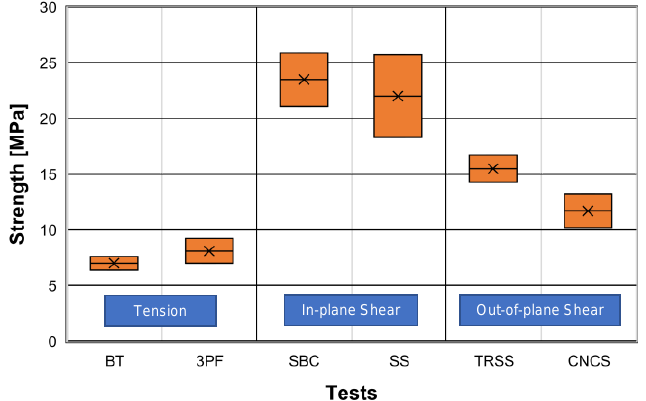
Figure 15. Variation in strength for the different tests.